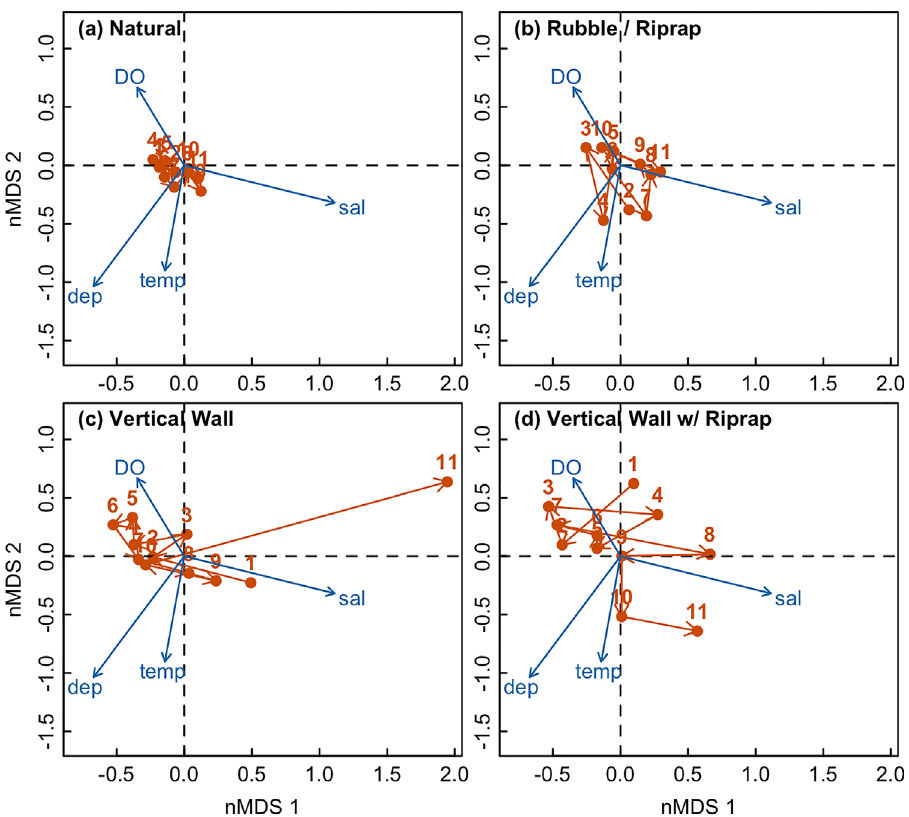
Fig 3. Non-metric multidimensional scaling (nMDS) plots for fish communities associated with each shoreline type. A single nMDS analysis was performed on the entire dataset (2-D stress = 0.13) and the results were plotted on four different panels based on shoreline type: (a) Natural, (b) Rubble with Riprap, (c) Vertical Wall, (d) Vertical Wall with Riprap. Blue vectors and labels indicate explanatory variables that are significantly correlated with the nMDS axes. Red arrows indicate the trajectory of communities over time, with the red labels representing year number.